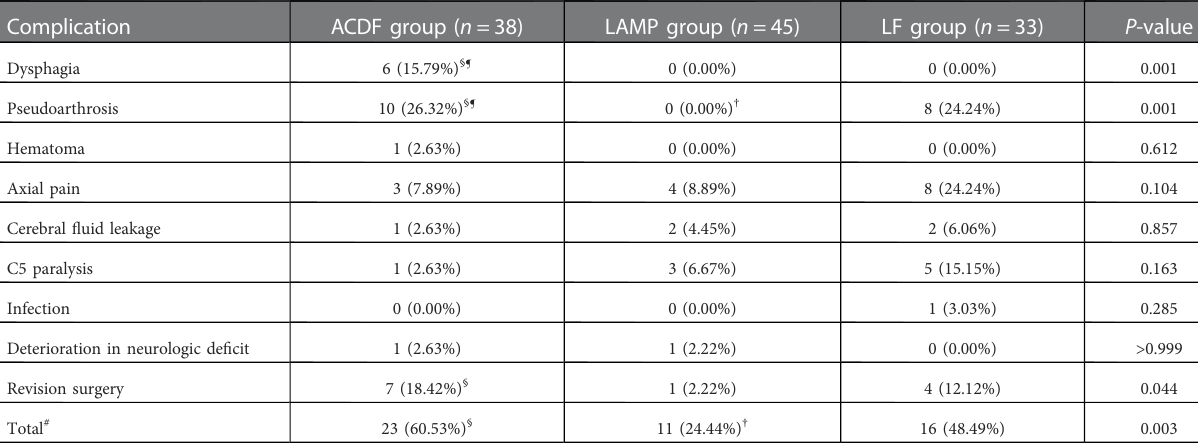
TABLE 5 Postoperative complications.